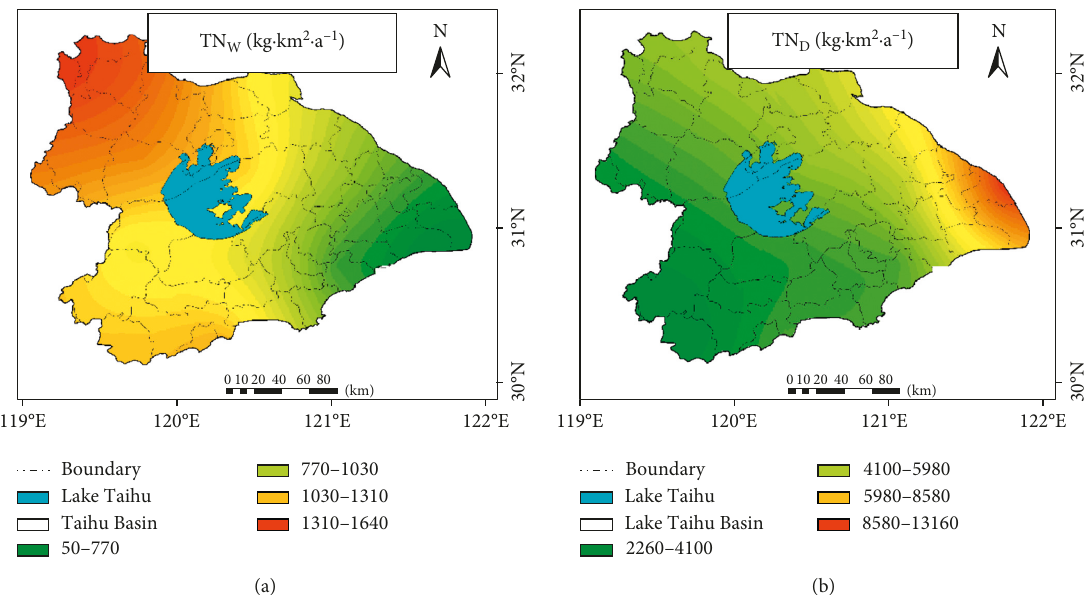
Figure 3: Spatial variations in N deposition (kg · km 2 · a − 1 ) in the Taihu watershed.